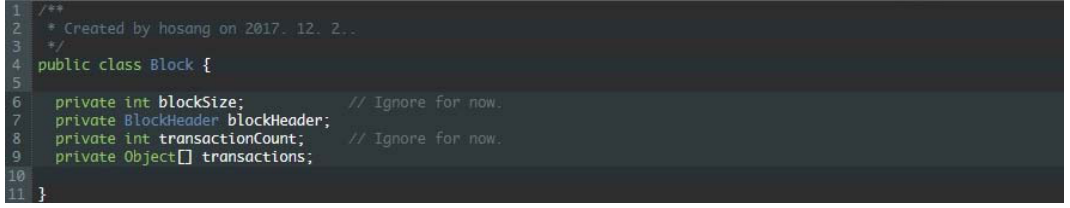
Figure 9. Rainbowchain equations.